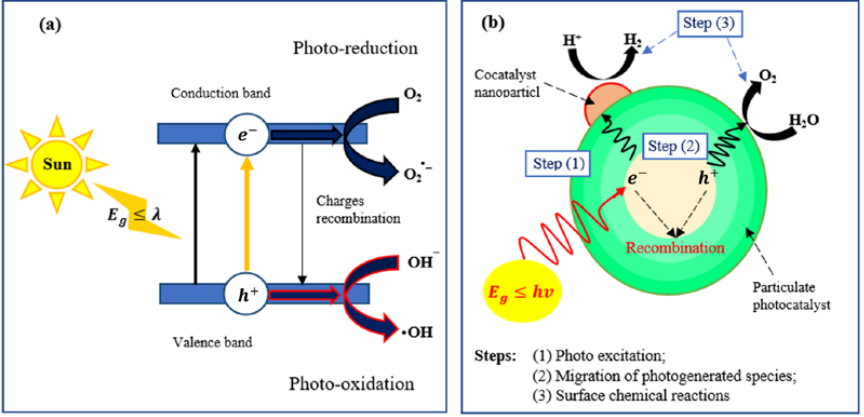
Figure 2. Photocatalytic reactions in semiconductors: ( a ) photocatalysis process and ( b ) three basic steps of photocatalysis in semiconductors.